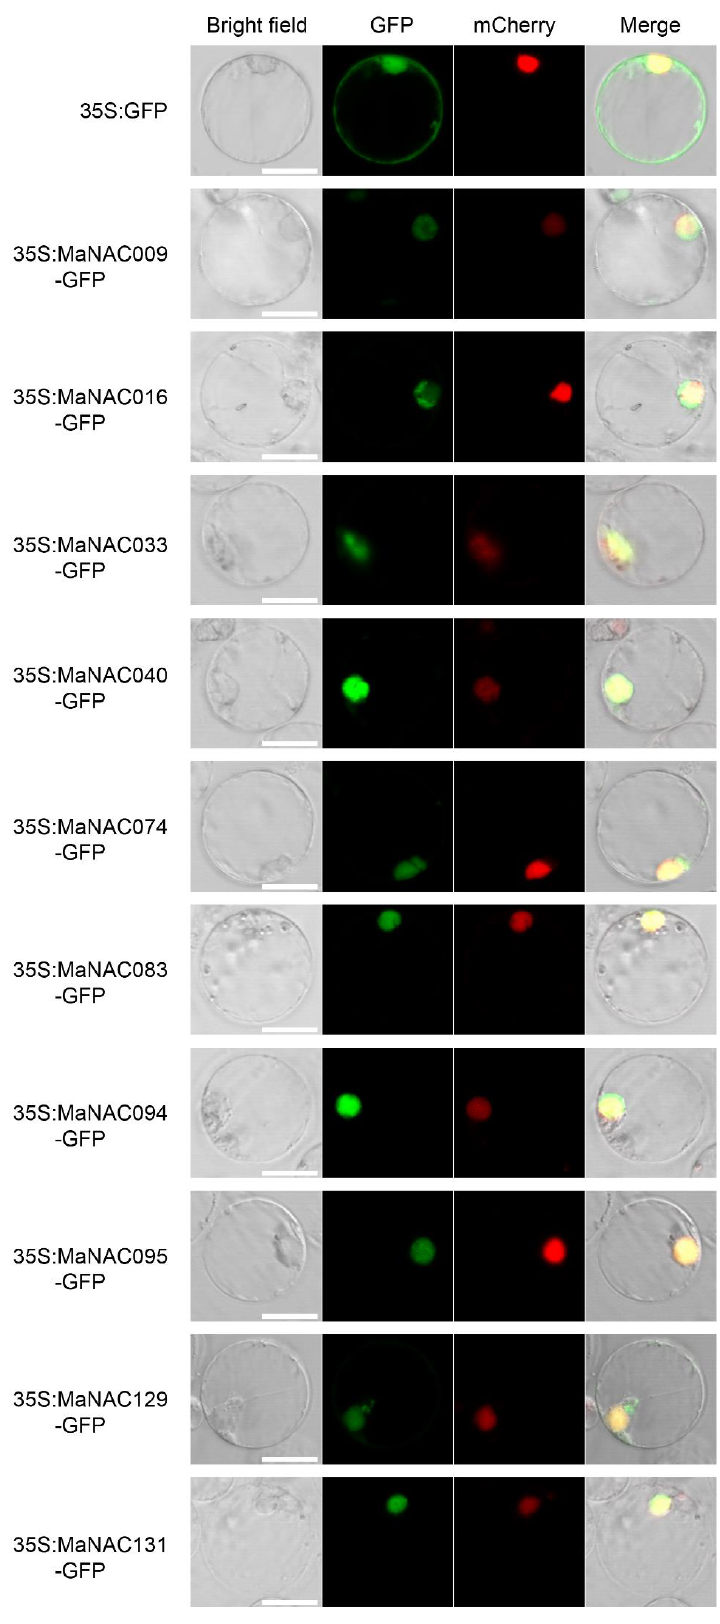
Figure 7. Subcellular localization of the selected 10 MaNACs cloned from M. acuminata and